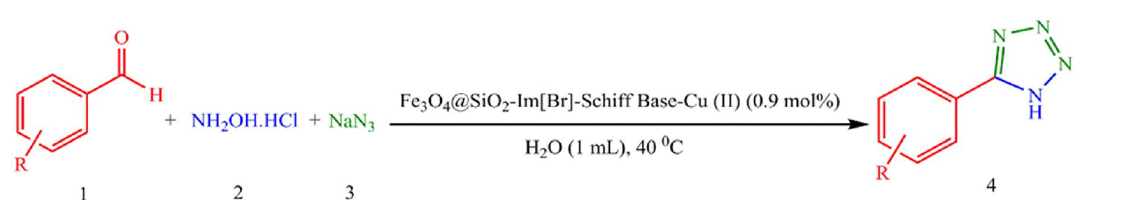
Figure 12. Plausible mechanism for the synthesis of 1-aryl 1 H -tetrazole derivatives.